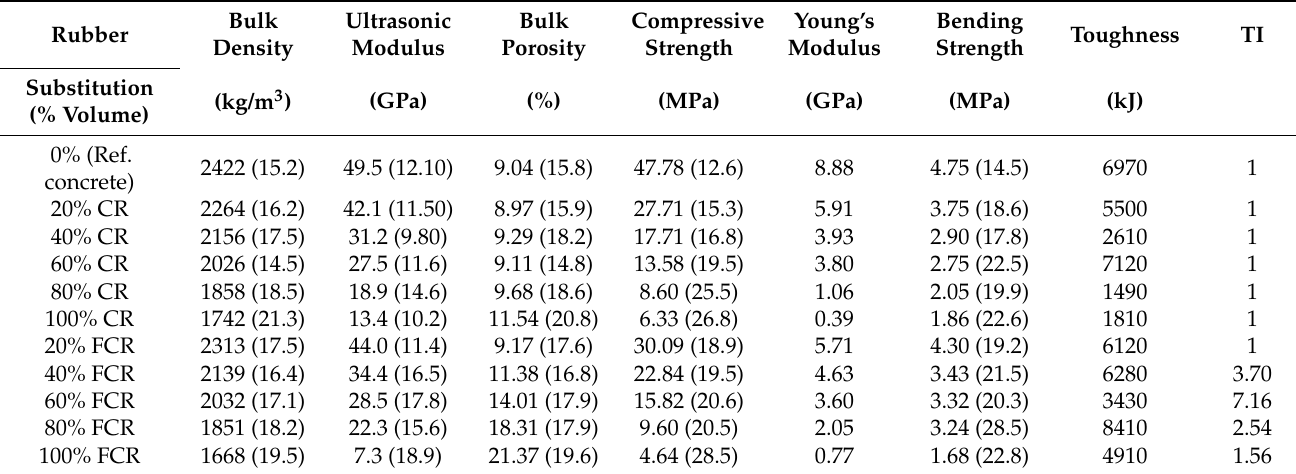
Table 6. Bulk density, bulk porosity, compressive strength, Young’s modulus, bending strength, toughness and tough- ness index (TI) results of concrete samples with CR an FCR. Deviation factor (%) is indicated between brackets [34]. Copyright© 2017, Elsevier B.V.